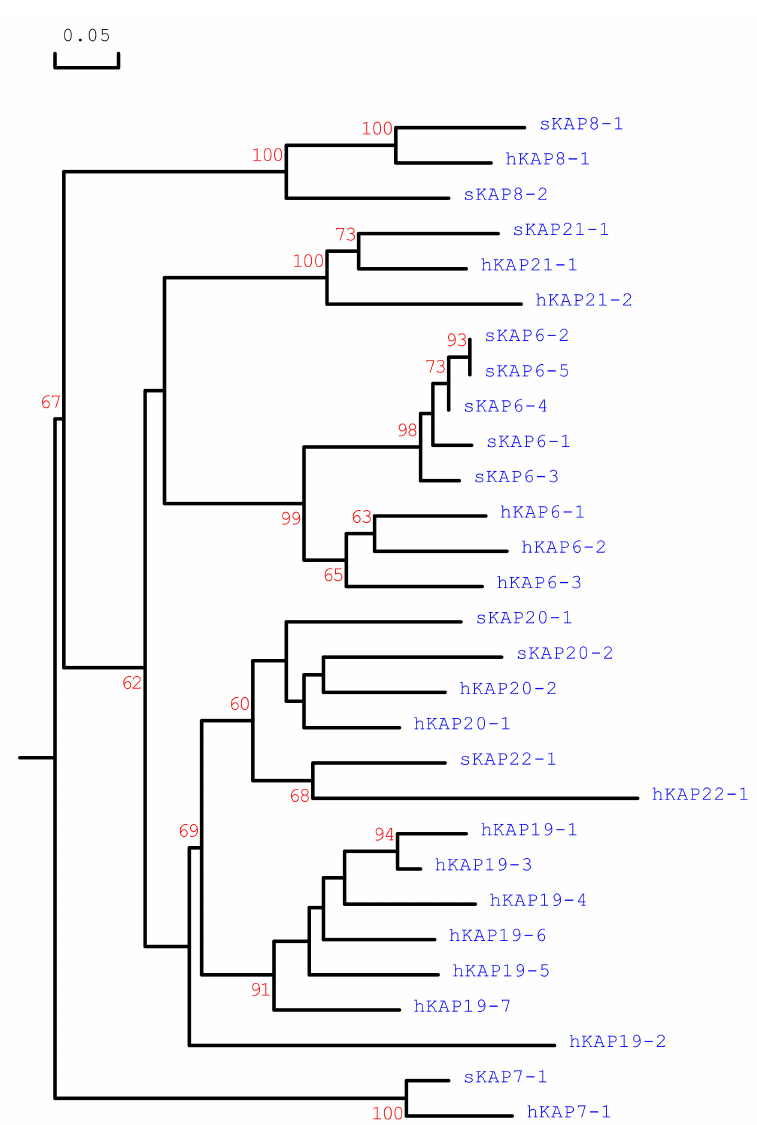
Figure 2. Phylogenetic tree of the newly identified ovine KAP21-1 along with other HGT-KAPs from sheep and humans. The tree was constructed using the predicted amino acid sequences. The numbers at the forks indicate the bootstrap confidence values and only those equal to, or higher than 60% are shown. Only one of the sheep KAP21-1 variants is shown as all of the four variants are identical at the amino acid sequence level. The sheep KAPs are indicated with a prefix “s”, while the human sequences are